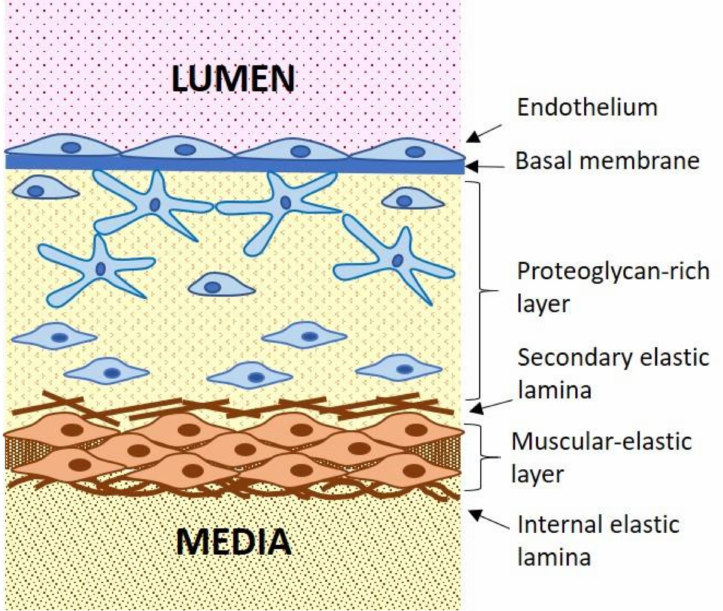
Figure 2. Schematic presentation of the arterial intima. Proteoglycan-rich layer contains several cell types, including stellate pericyte-like cells and modified smooth muscular cells with reduced